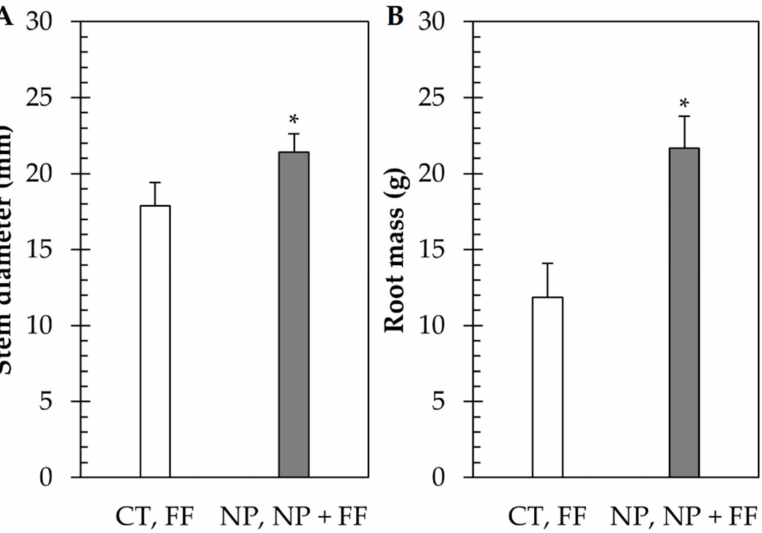
Figure 7. Biomass productivity of maize in different treatments. ( A ) Stem diameter; ( B ) Root mass. Data represent mean ± SD (n = 5); CT: untreated control; FF: foliar fertilizer; NP: nitrapyrin; NP + FF: joint treatment of nitrapyrin and foliar fertilizer. Asterisks (*) indicate significant differences (Student’s t -test, p < 0.05) between nitrapyrin-treated and control plants.